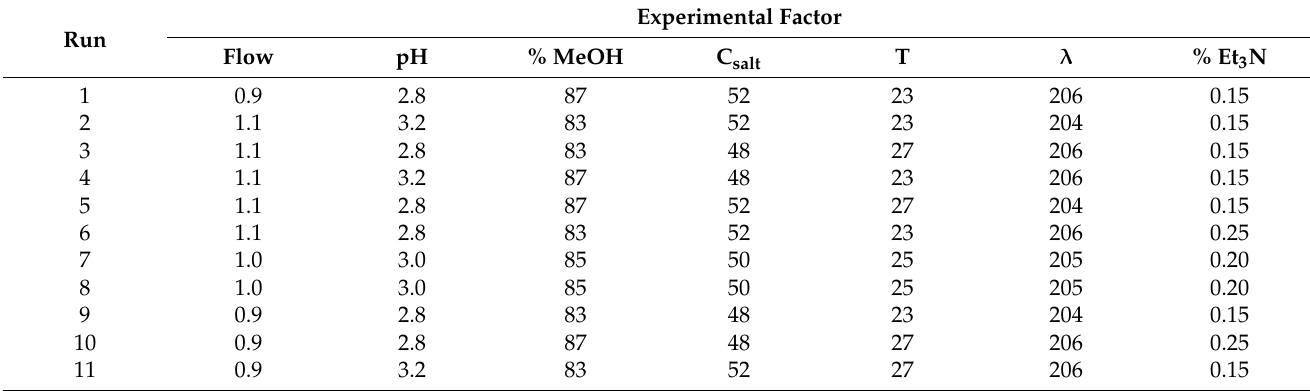
Table 2. All the experiments proposed by the